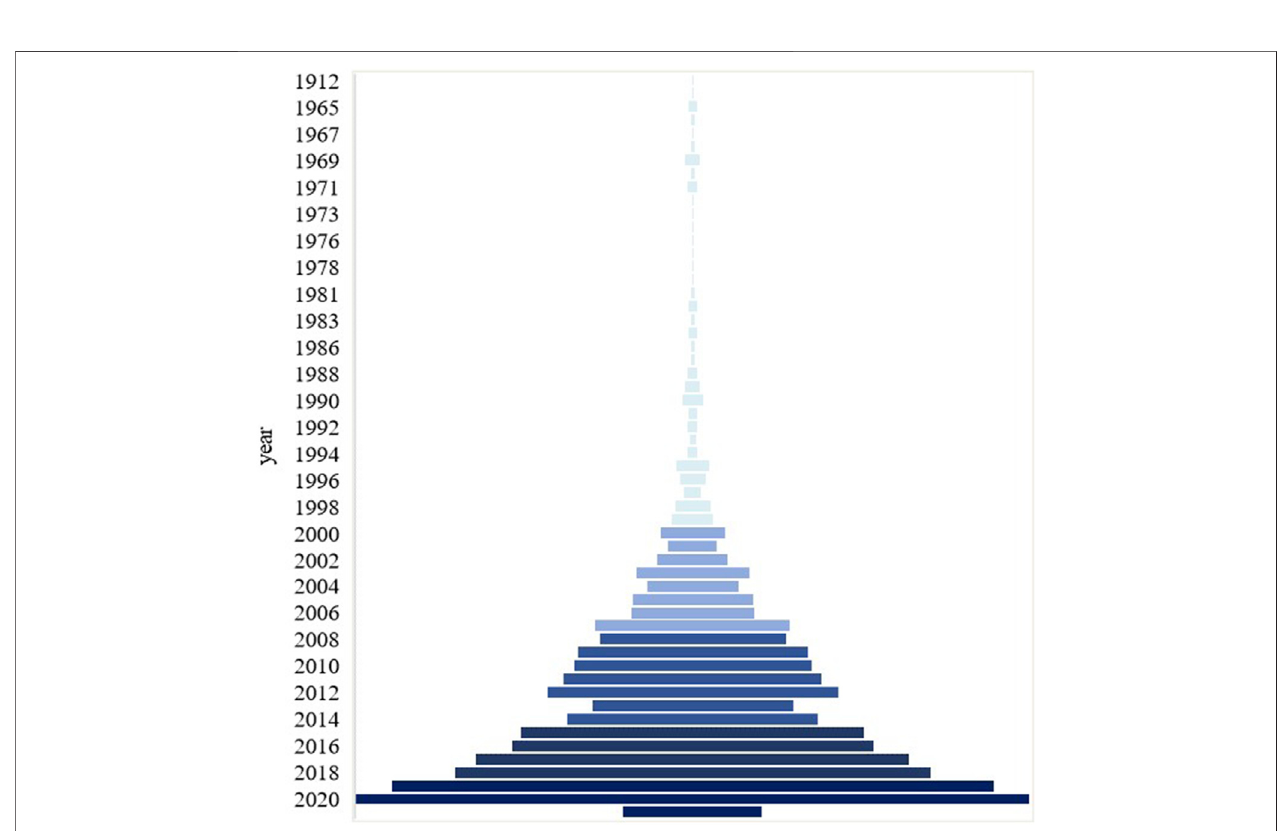
FIGURE 2 | Annual scienti fi c production in a longer period.